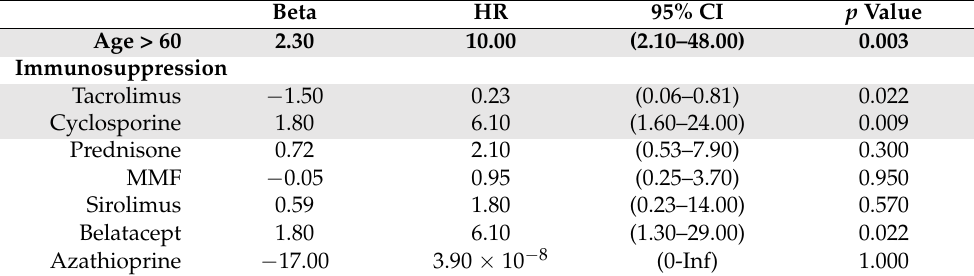
Table 2. Univariate Cox Regression Model of Selected Variables.